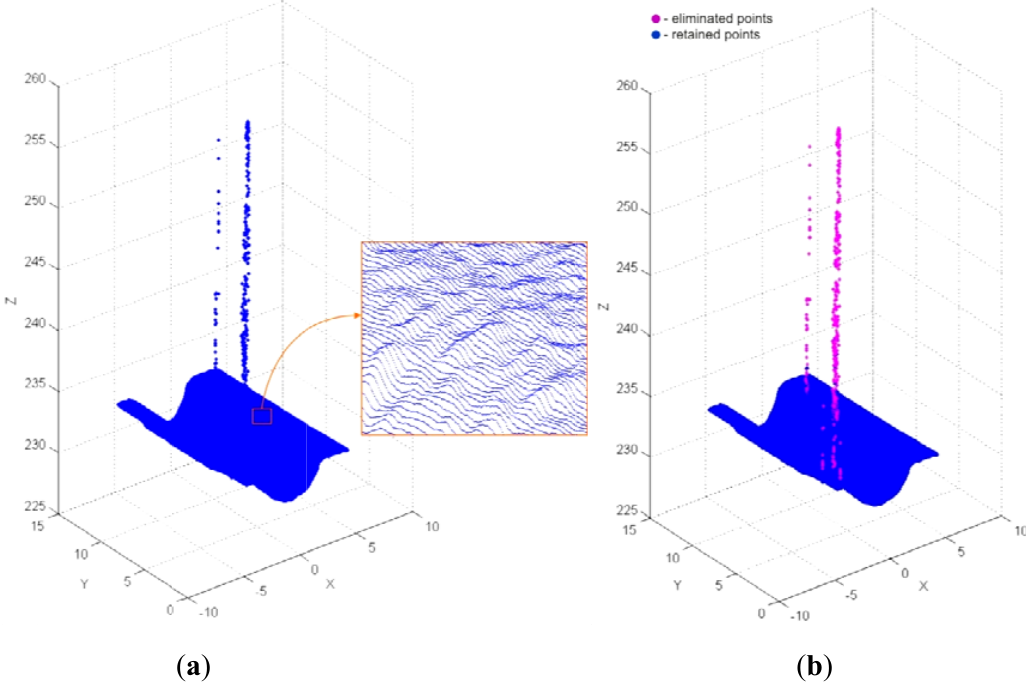
esult of 3D gle.